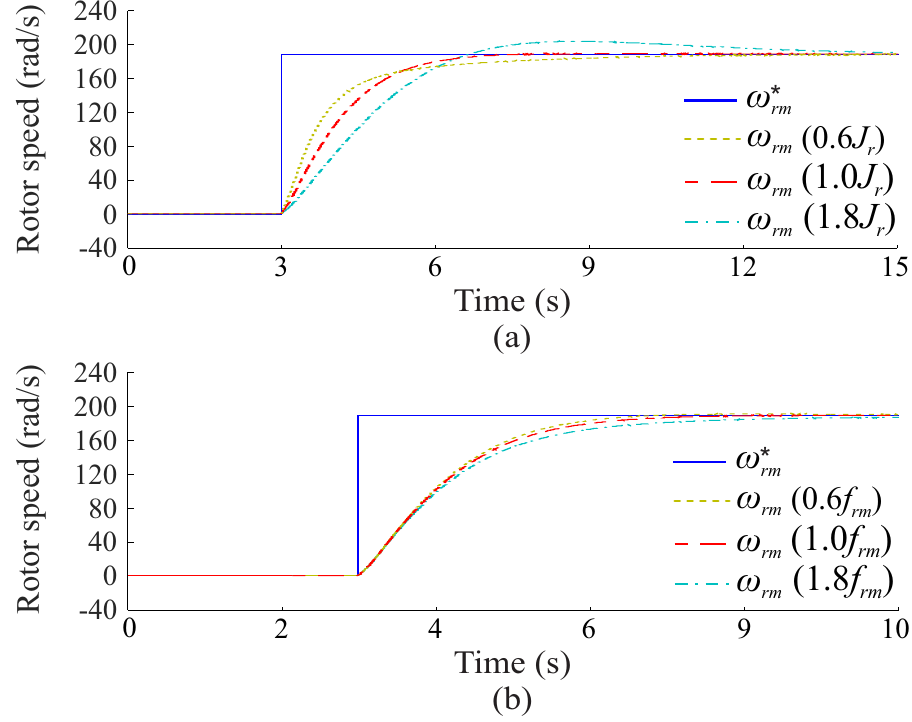
Figure 15. Dynamic response of the speed controller to ( a ) J r variations and ( b ) f rm